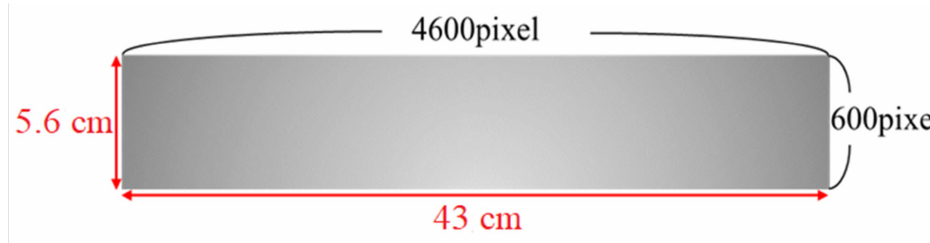
Figure 16. The relationship between the pixels and the actual size of the captured